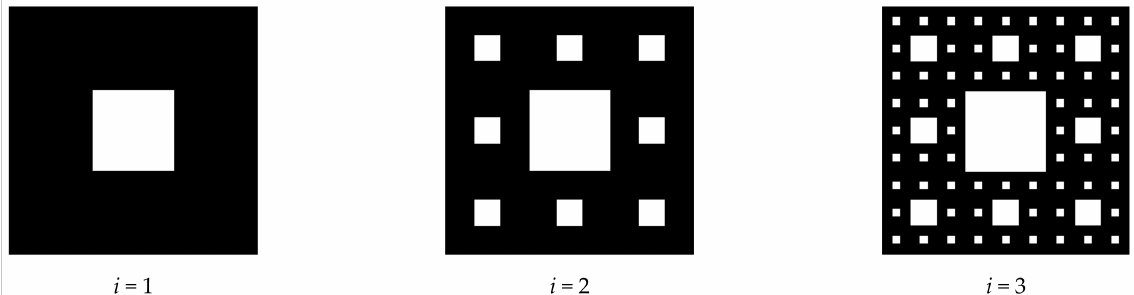
Figure 3. Solid mass fractal model. The black part is solid, and the white part is pore ( d E = 2, b = 3, z = 8/9, m = 1, D = 1.893).